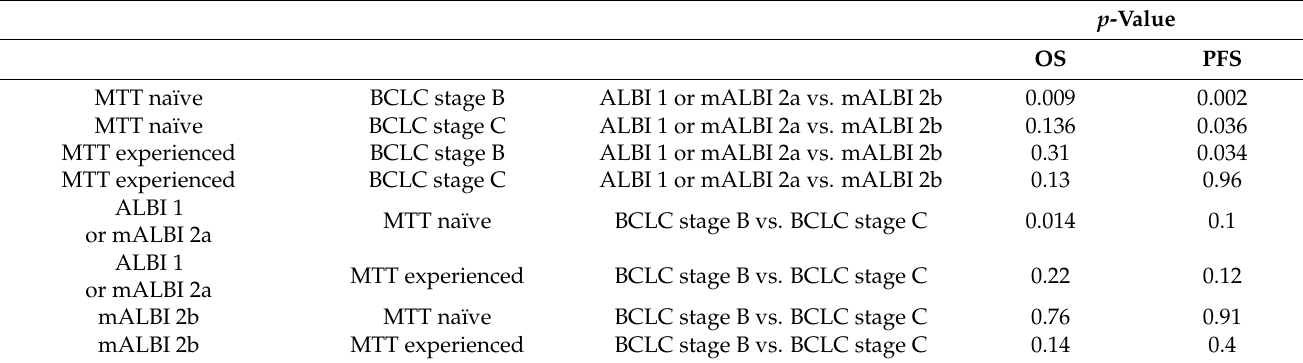
Table 4. The statistical comparisons according to BCLC stage, MTT experience, and ALBI grade.